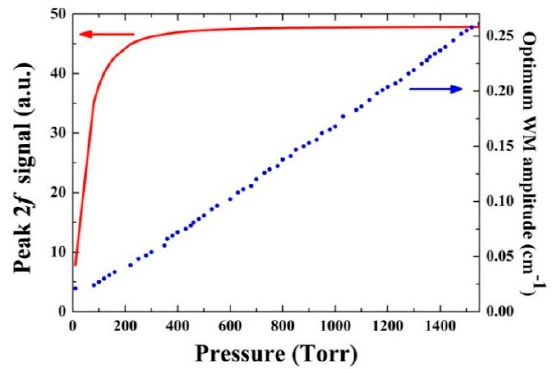
Figure 5. Optimum wavelength modulation amplitude A p P q (circles) and the corresponding CO 2 f absorption peak α 0 p P q (line) as a function of the gas pressures.